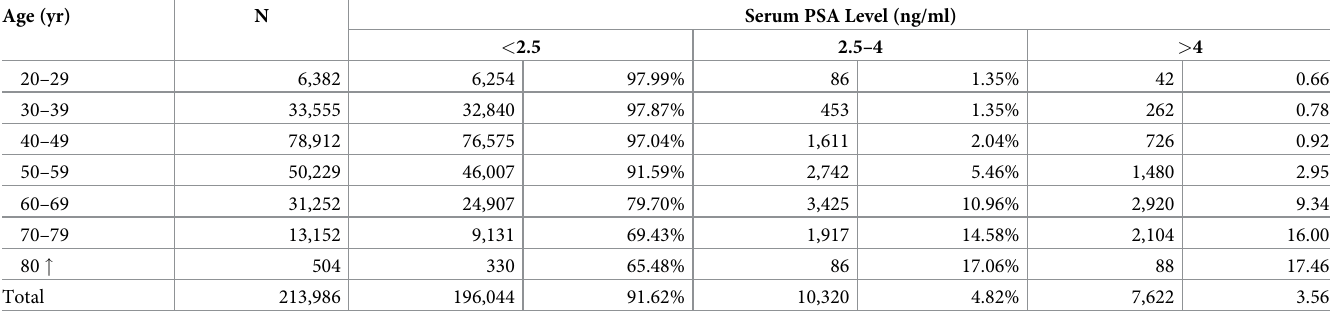
Table 2. Proportion of men with various serum PSA levels according to age. Age